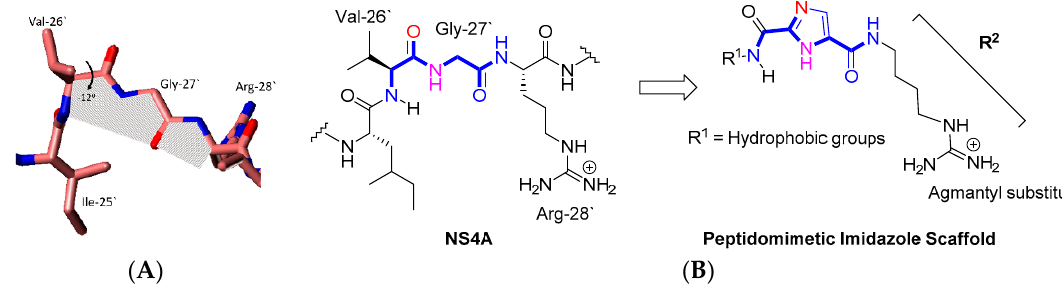
Figure 1. ( A ) The planar kink region of nonstructural (NS)4A extracted from crystal structure 1NS3 (Protein Data Bank (PDB) Code: 1NS3) is shadowed. ( B ) De novo design of 1 H -imidazole-2,5-diamide derivatives that mimic this planar area.